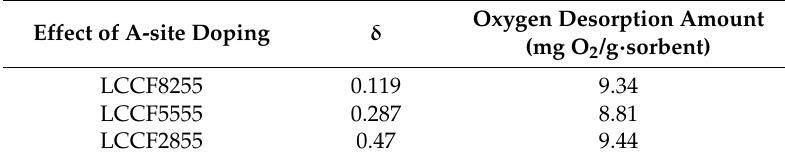
Table 4. Effect of A-site doping on δ and performance of La 1 − x Ca x Co 0.5 Fe 0.5 O 3 − δ (x = 0.2, 0.5, 0.8).